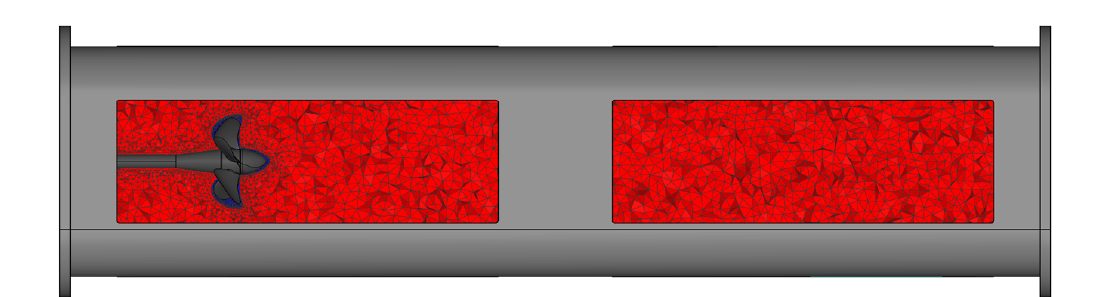
Figure 6. Acoustic finite element (FE) mesh inside the cavitation